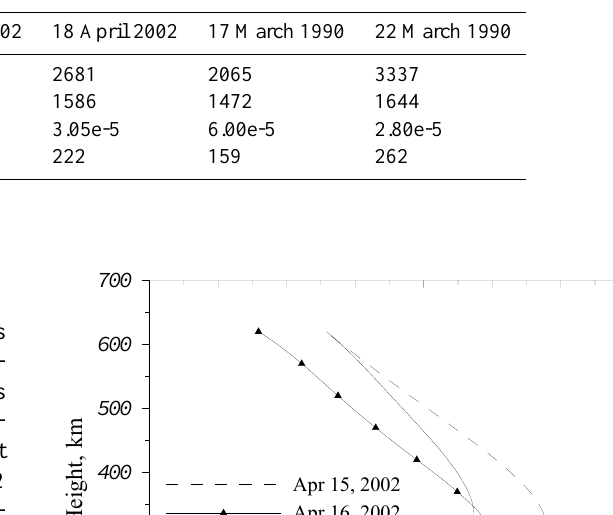
(Fig. 5, bottom panel), but a similar effect with